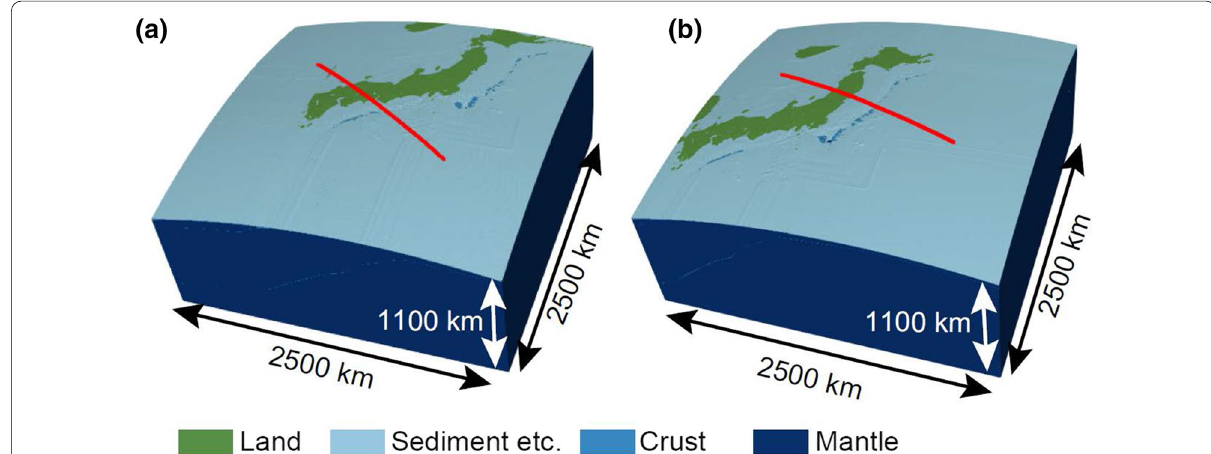
Fig. 4 Overview of the FE models. The FE model of the a Nankai Trough and the b Japan Trench subduction zones. The red lines denote the locations of the seismic velocity profiles shown in Fig.